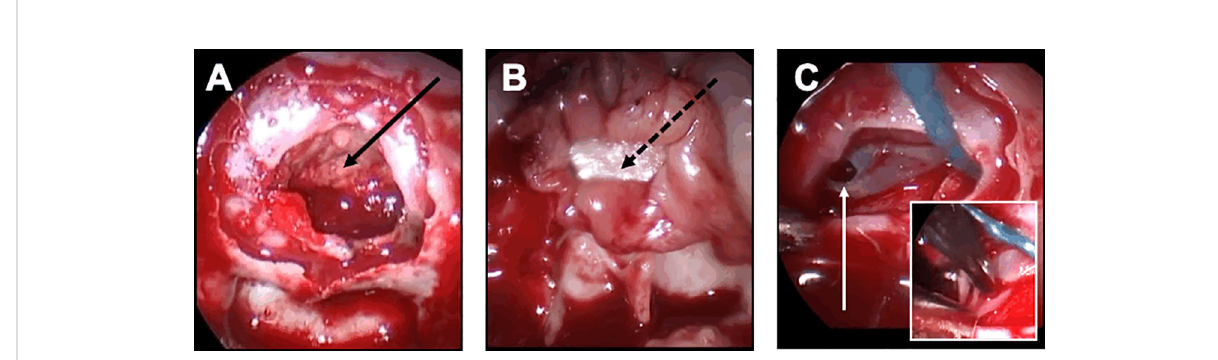
FIGURE 4 Closure strategy in patients with CSF leak and no risk factor. For these patients, the sella fl oor should be reconstructed and biological glue should be applied after the sealing has been achieved. (A, B) Minimal and diffuse fl ow diaphragm leak. (A) A sealant collagen sponge coated with the human coagulation factors fi brinogen and thrombin (black arrow) has been designed, positioned in the intrasellar compartment, deployed, centered on the dural defect and applied against the diaphragm with the help of a forceps holding a cottonoid and a suction tube. (B) An epidural duraplasty has been performed, using the mucosa of the right middle turbinate. After the mucosa has been embedded in the epidural space with a bone graft (black dotted arrow), the mucosa acts as a seal. (C) Focal low- fl ow leak. A unique focal defect is visualized on the right side of the diaphragm (white arrow). The sealing is achieved after coagulation of the dural defect using a bipolar forceps